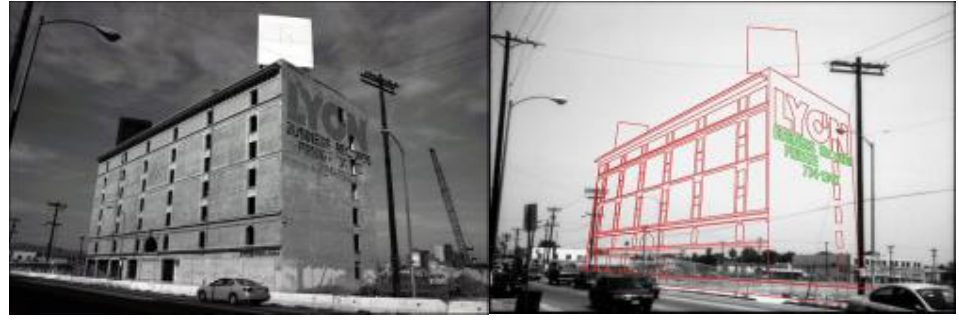
Carlos Garaicoa, Sin título, L.A. [ Untitled, L.A .], 2004. Diptych. Photographs and drawing with thread, mounted and laminated on black gator board. 125 x 175 cm each. Copyright Carlos